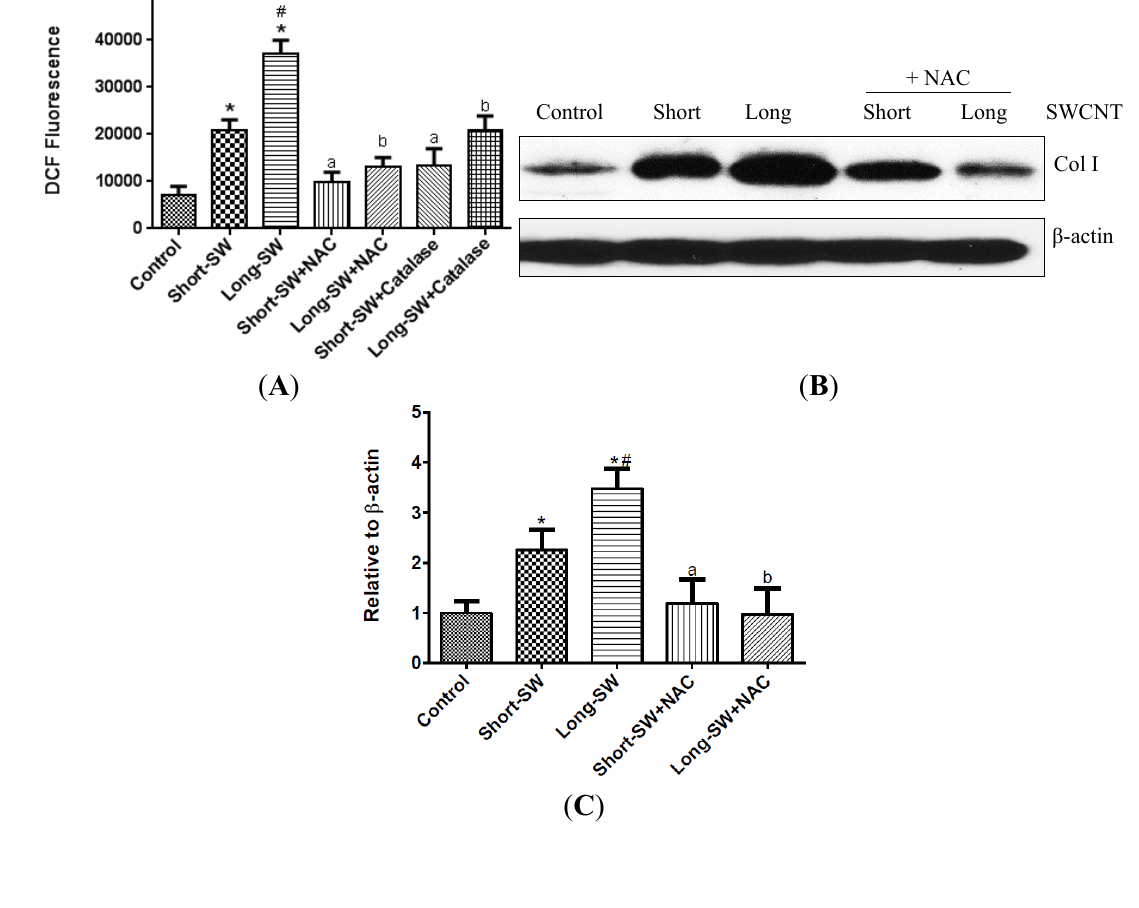
Figure 2. Effect of SWCNT length on reactive oxygen species (ROS)